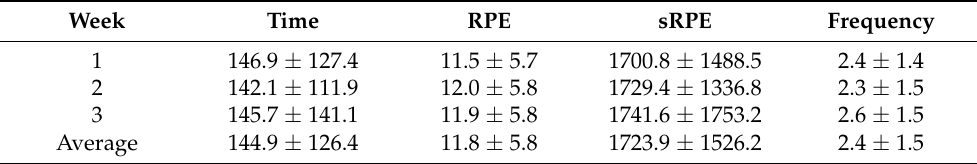
Table 3. Mean and standard deviation of the time (minutes), rate of perceived exertion (RPE), session RPE (sRPE), and frequency (times per week) for outside the La Crosse Exercise and Health Program.